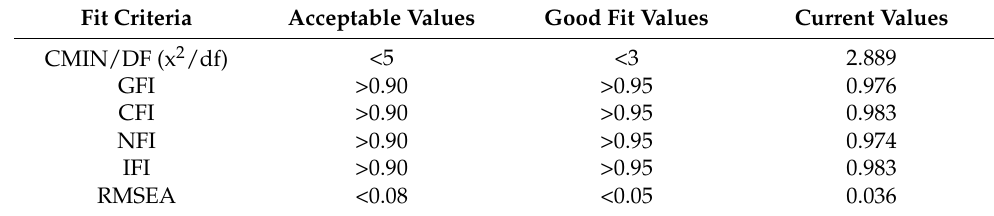
Table 2. Confirmatory factor analysis values.